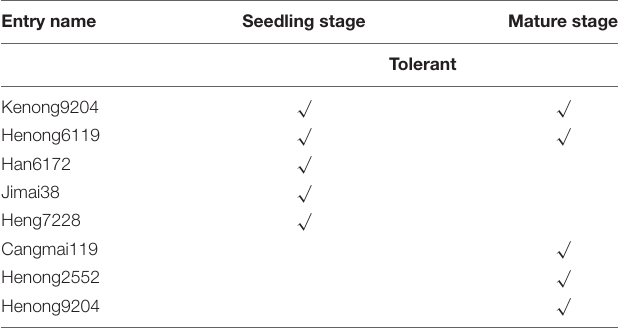
TABLE 3 | Low-K tolerant genotypes identified based on the D values in more than one growth stage.